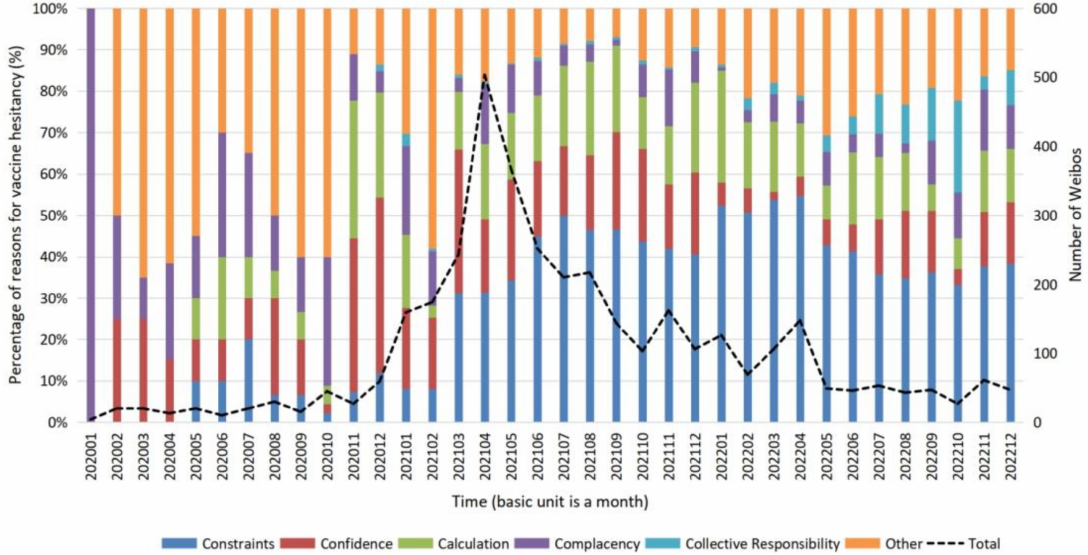
Figure 1. Changes in the number of Weibos and reasons for vaccine hesitancy over time. From the bar chart, from 2020 to 2022, the proportion of vaccine hesitancy caused by constraints is getting higher, and the proportion of vaccine hesitancy caused by others is getting lower. Confidence and calculation have a more similar proportion